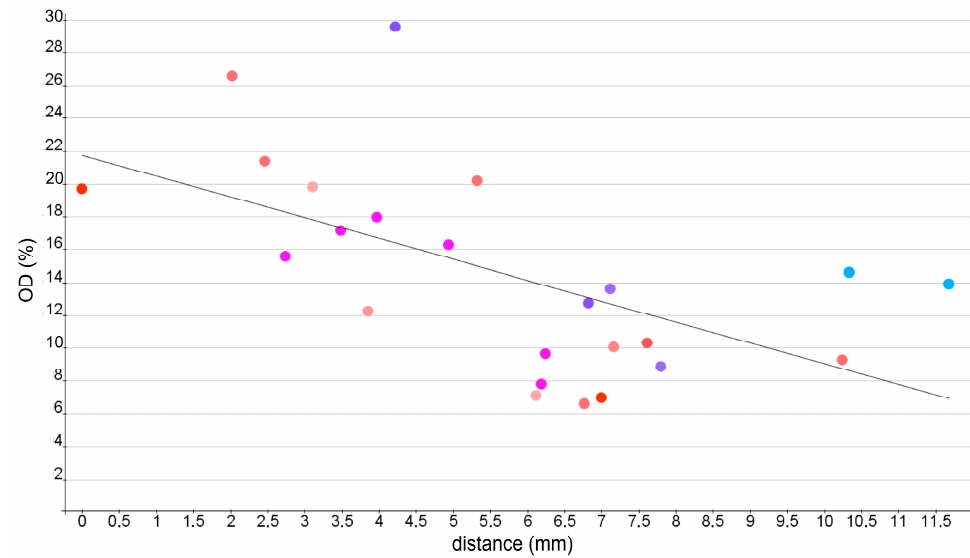
Figure 10. On the diagram, the OD of the examined brain areas is plotted against their distance from the treated CPu. The values of an ipsilateral and corresponding contralateral brain area are plotted with the same color. The black line is the regression line.